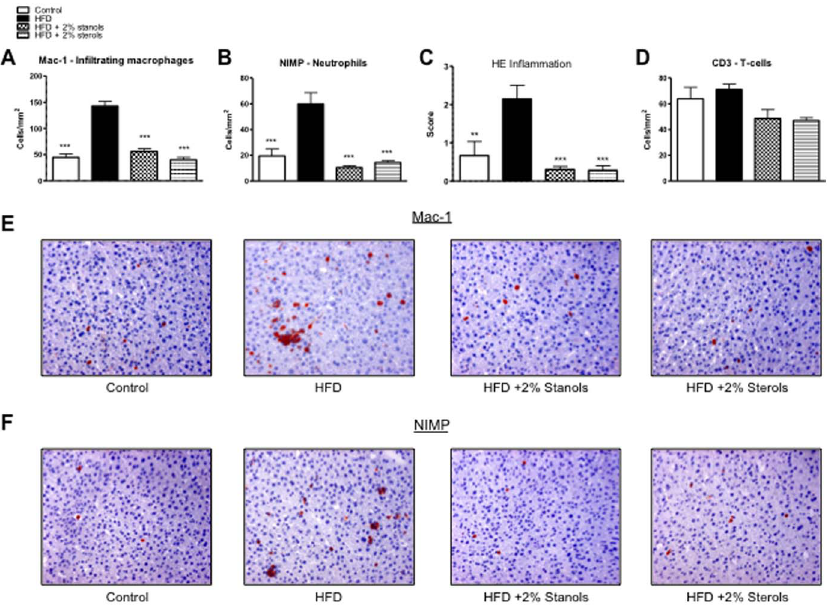
Figure 1. Parameters of hepatic inflammation. (A, B) Liver sections were stained for infiltrating macrophages and neutrophils (Mac-1) and neutrophils (NIMP). From each liver, 6 random pictures were taken at 200x magnification to cover the whole slide. Positive cells for the specific staining were then counted being indicative for inflammation (C) Result of scoring for inflammation by an experienced pathologist using the HE staining in all groups. (D) Liver sections were stained for T-cells (CD3) and positive cells counted. (E, F) Representative pictures of Mac-1 staining and NIMP staining in the four experimental groups (200x magnification). *P , 0.05, **P , 0.01, and ***P , 0.001, respectively.